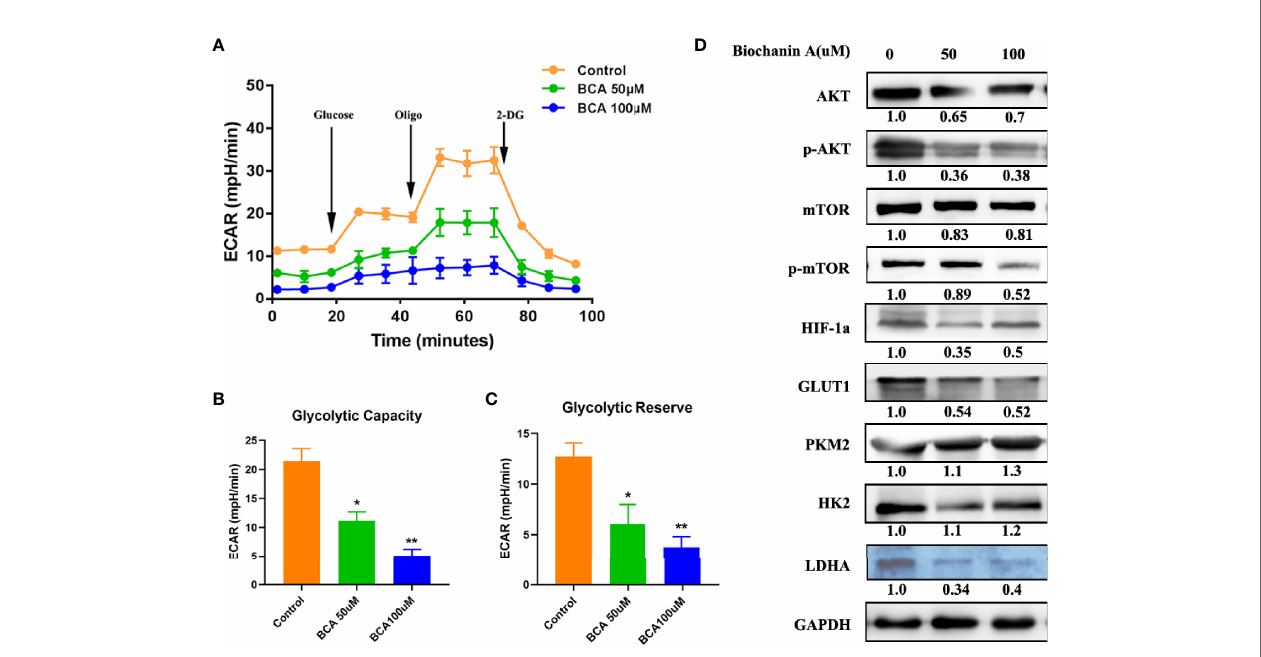
FIGURE 4 | BCA decreases the Glycolytic Capacity of U251 cells. (A) Glycolytic stress test to detect glycolytic activities in BCA (0, 50, 100 uM) group; (B) Quanti fi cation of the glycolytic capacity in A; (C) Quanti fi cation of the glycolytic reserve in A; (D) Western blot analysis of relative proteins of Glycolytic (AKT, p-AKT, mTOR, p-mTOR, HIF-1a, GLUT1, PKM2, HK2, and LDHA). *P < 0.05, **P < 0.01 versus